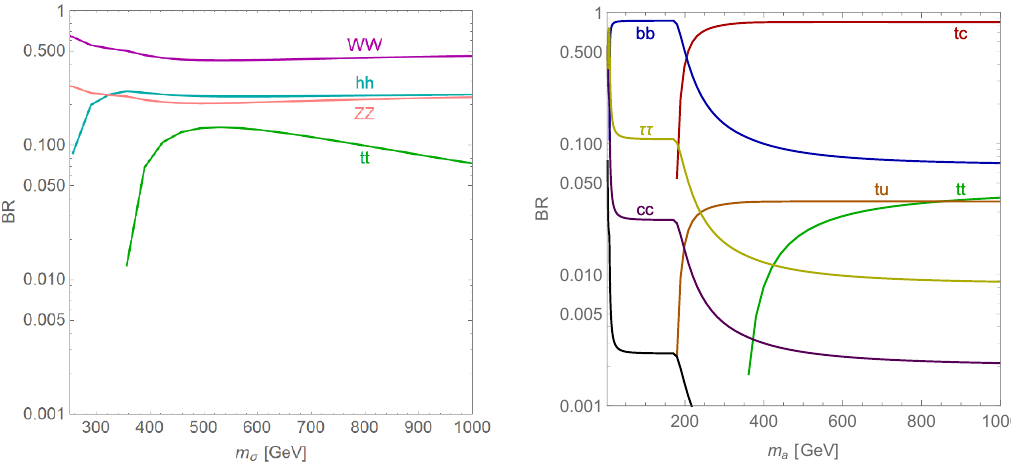
Figure 2 . The branching fractions of the CP-even (left) and CP-odd (right)